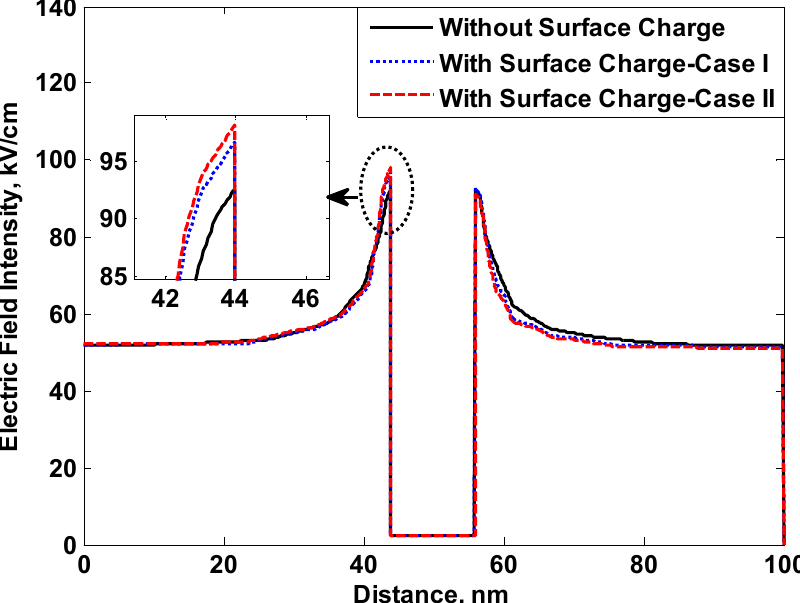
Figure 17. Electric field distortion considering accumulation of surface charges on nanoparticle surface (Nanoparticle material dielectric constant = 100).